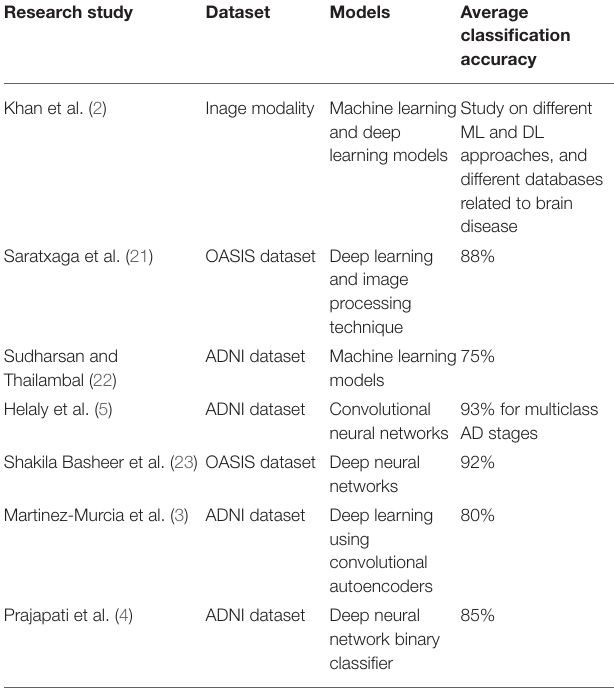
TABLE 1 | Summary of recent work related to AD.